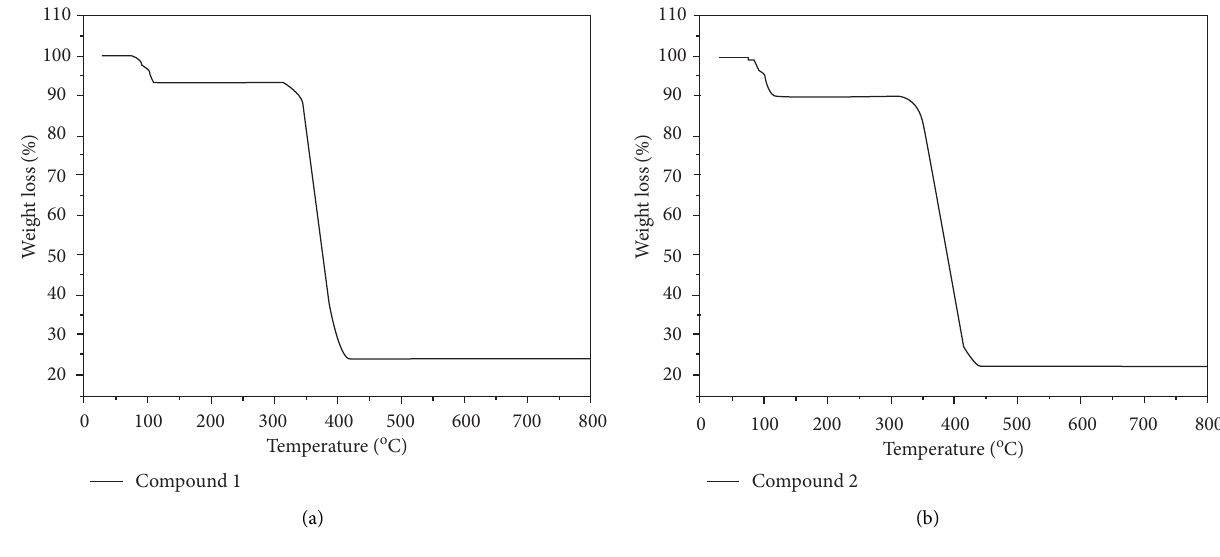
Figure 3: The curves of TGA (a) for the compounds 1 and (b) 2.